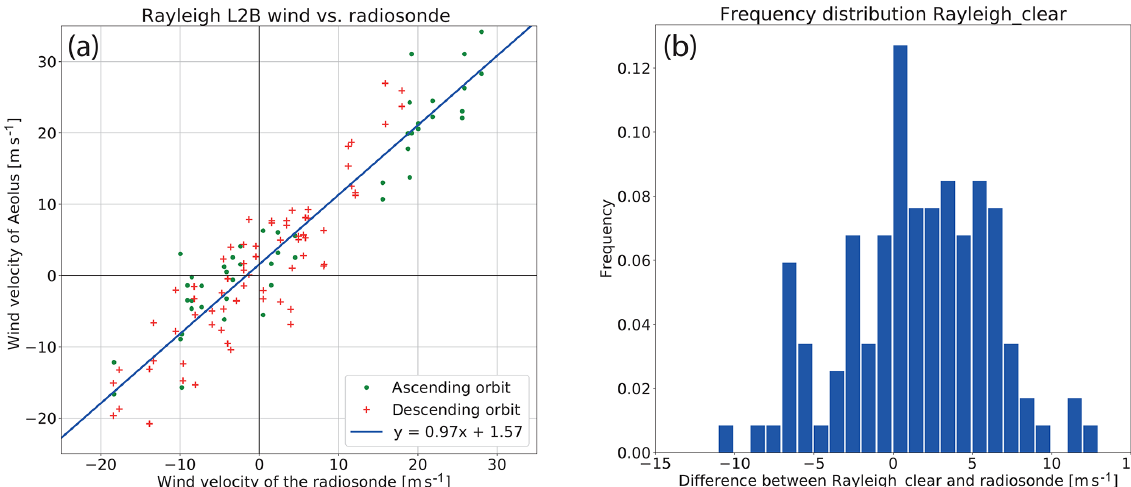
Figure 10. (a) The L2B Rayleigh clear winds versus the radiosonde measurements made during the ship-borne validation except for 27 November 2018. Green represents measurements of an ascending orbit, while red represents measurements of a descending orbit. (b) Fre- quency distribution of the difference between Rayleigh clear and radiosonde wind speeds for the same data set. Radiosonde data are aggregated to the Aeolus vertical resolution and projected to the HLOS of